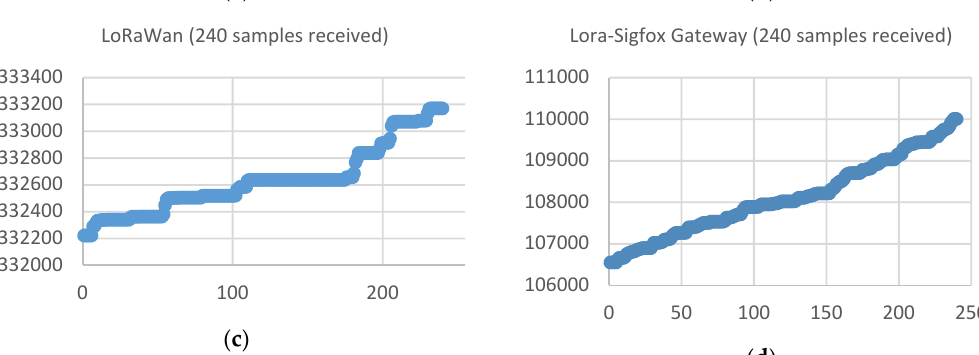
Table 3. Reception rates over a period of 10 days (240 samples) with each of the different systems tested in a water-meter with a percentage of received samples ranged higher than 75% over expected in the 169MHz ISM band.